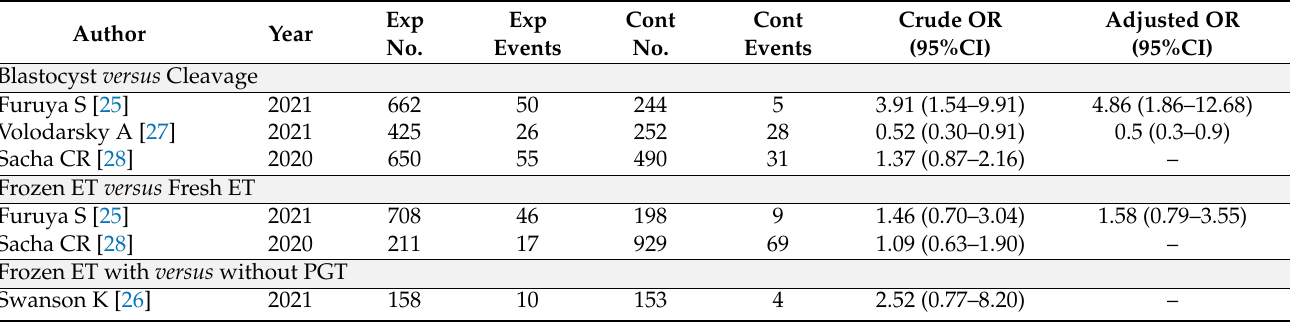
Table 2. Risk of VCI according to ART